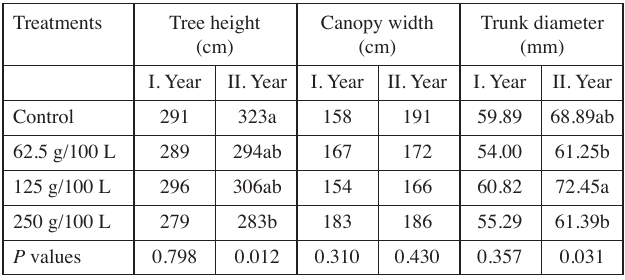
Tab. 1: The effect of Pro-Ca dosage on some vegetative growth in the ‘Star- crimson Delicious’ apple cultivar Treatments